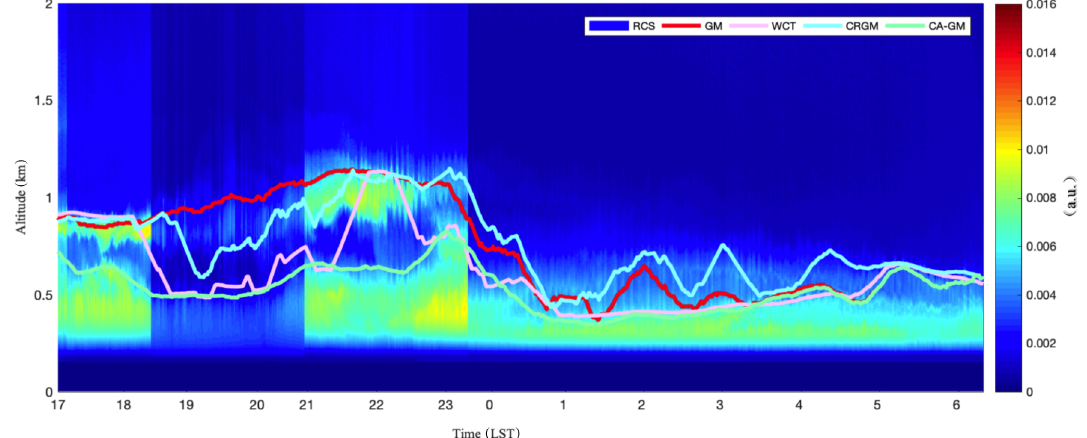
Figure 12. Time–height cross section of RCS with four NBLH retrieval methods. The discontinuity of the RCS at 18:06–18:07LST is the result of detecting electric noise. The discontinuities of RCS at 20:39–20:58LST and 23:18–23:39LST were because of the laser energy adjustment and the signal